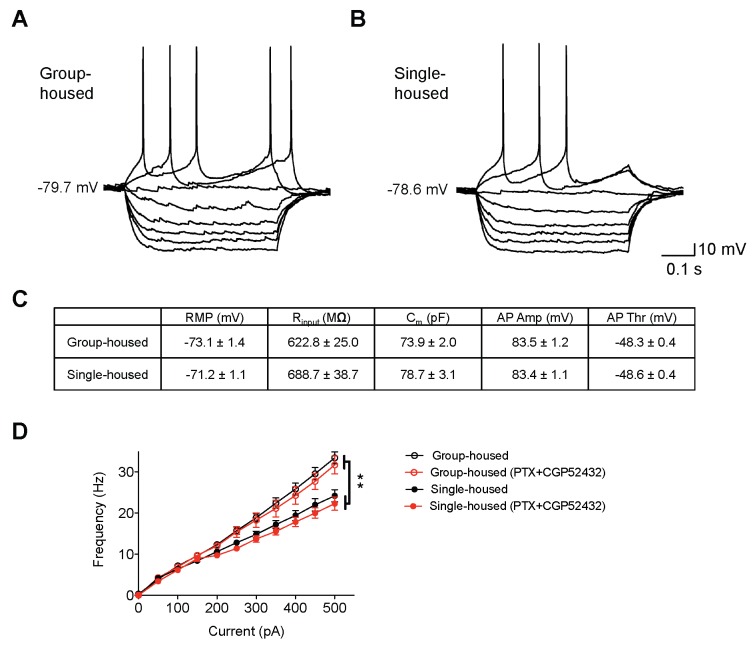
Membrane characteristics of dorsal raphe 5-HT neurons from group-housed and single-housed mice are similar.Current-clamp traces of a 5-HT neuron from a group-housed (A) and a single-housed (B) mouse in response to depolarizing and hyperpolarizing currents injected in a stepwise manner (25 pA steps). (C) Membrane properties of dorsal raphe 5-HT neurons from group- (n = 6 mice, 35 neurons) and single-housed (n = 5 mice, 41 neurons) mice. (D) Input-output curve showing spike frequency (Hz) of 5-HT neurons in response to a series of depolarizing current (pA) injections before and after application of GABAA and GABAB receptor blockers (picrotoxin, abbreviated as PTX, and CGP52432). The firing frequency (Hz) of 5-HT neurons from single-housed mice (Baseline; n = 10, +PTX+CGP52432; n = 13 neurons) is reduced compared to 5-HT neurons from group-housed mice (Baseline; n = 14, +PTX+CGP52432; n = 7 neurons) in the absence or presence of GABA receptor blockers (two-way repeated-measures ANOVA, main effect of group, F
(3400) = 9.2, p<0.001). Posthoc tests showed that there was a significant difference between group- and single-housed mice in the presence or absence of GABA receptor blockers (p<0.01). Blocking GABA receptors did not cause a significant change in neurons from either group- or single-housed mice (p’s > 0.05). Data are mean ± S.E.M. RMP, resting membrane potential; Rinput, input resistance; Cm, membrane capacitance; AP Amp, action potential amplitude; AP Thr, action potential threshold.